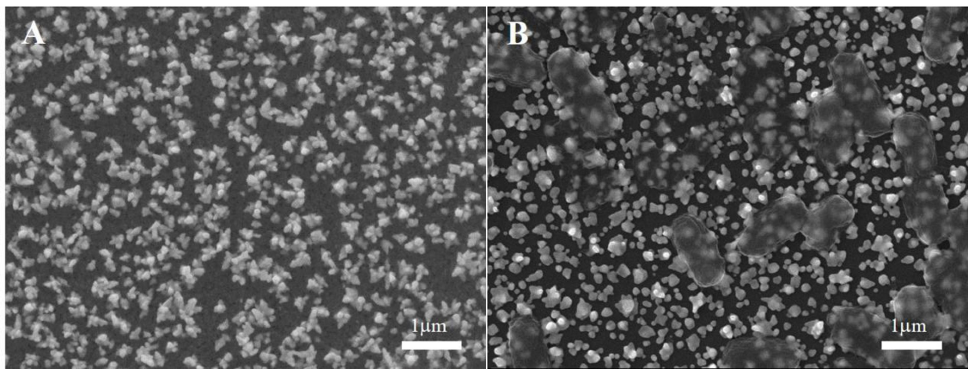
Figure 2. SEM images of ( A ) apt/LNA/Au/GCE and ( B ) SE/apt/LNA/Au/GCE.